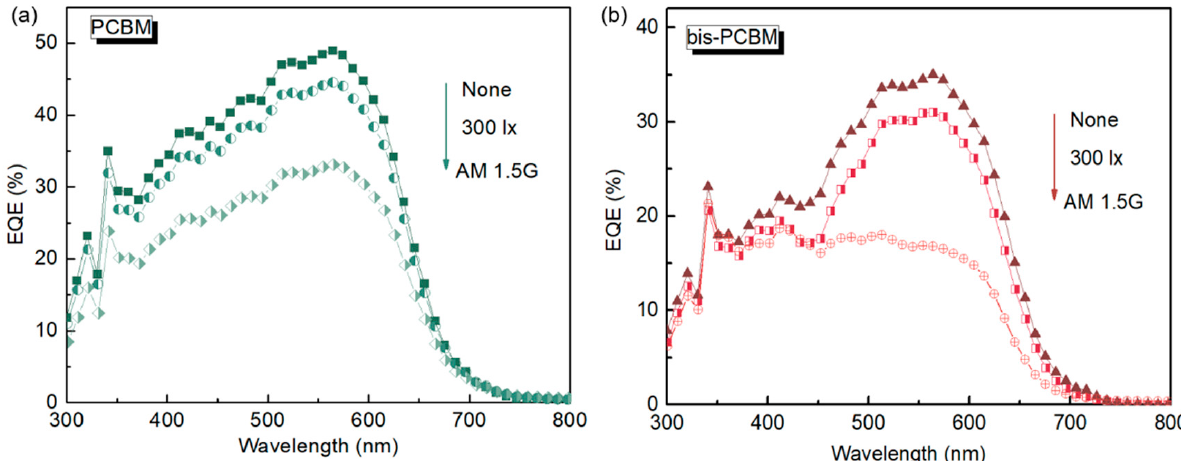
Figure 4. EQE of the OPV devices based on PCDTBT blended with PCBM ( a ) and bis-PCBM ( b ) after degradation under AM 1.5G or 300 lx indoor light, in air, for 60 min. EQE of the undegraded devices was used as references.